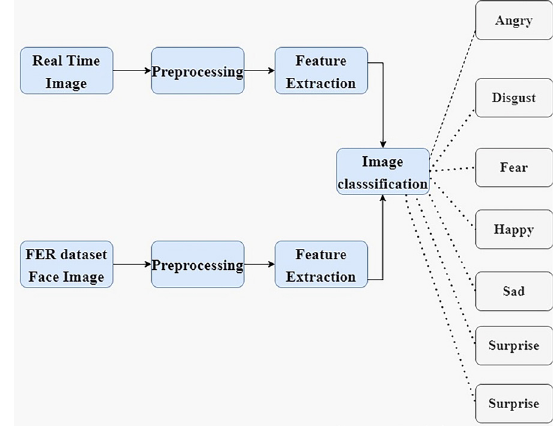
Fig. 3. Image Processing System Architecture